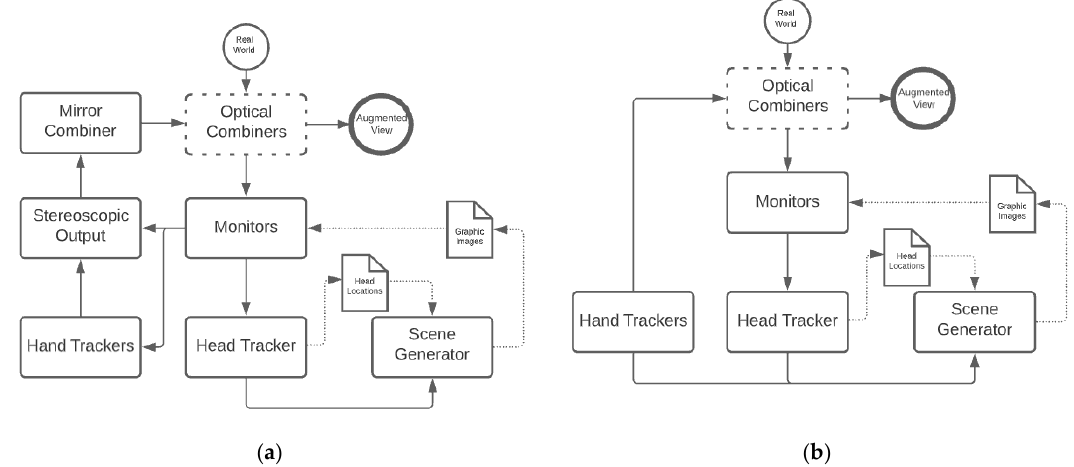
Figure 4. ( a ) Mirror-based AR with Controllers, ( b ) AR with Controllers and no Mirror.